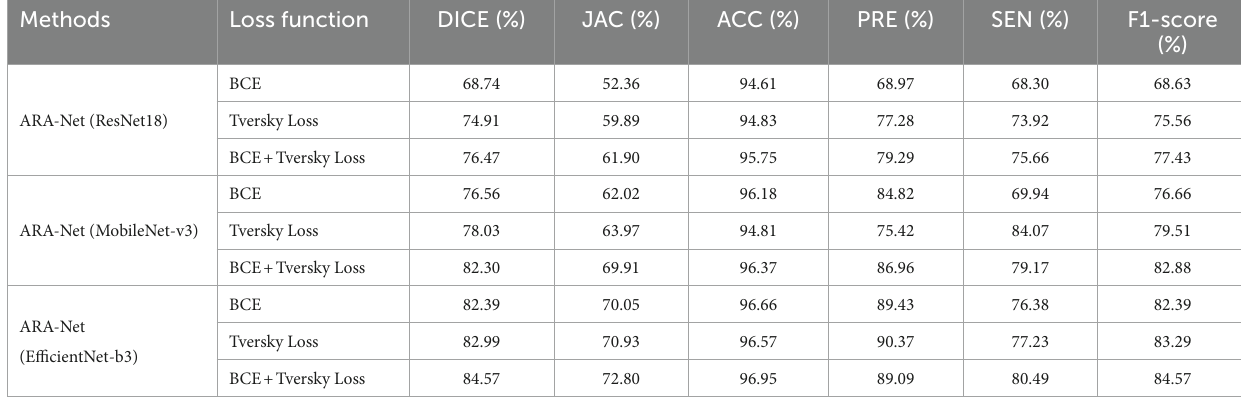
TABLE 3 Performance comparison of the methods across different loss